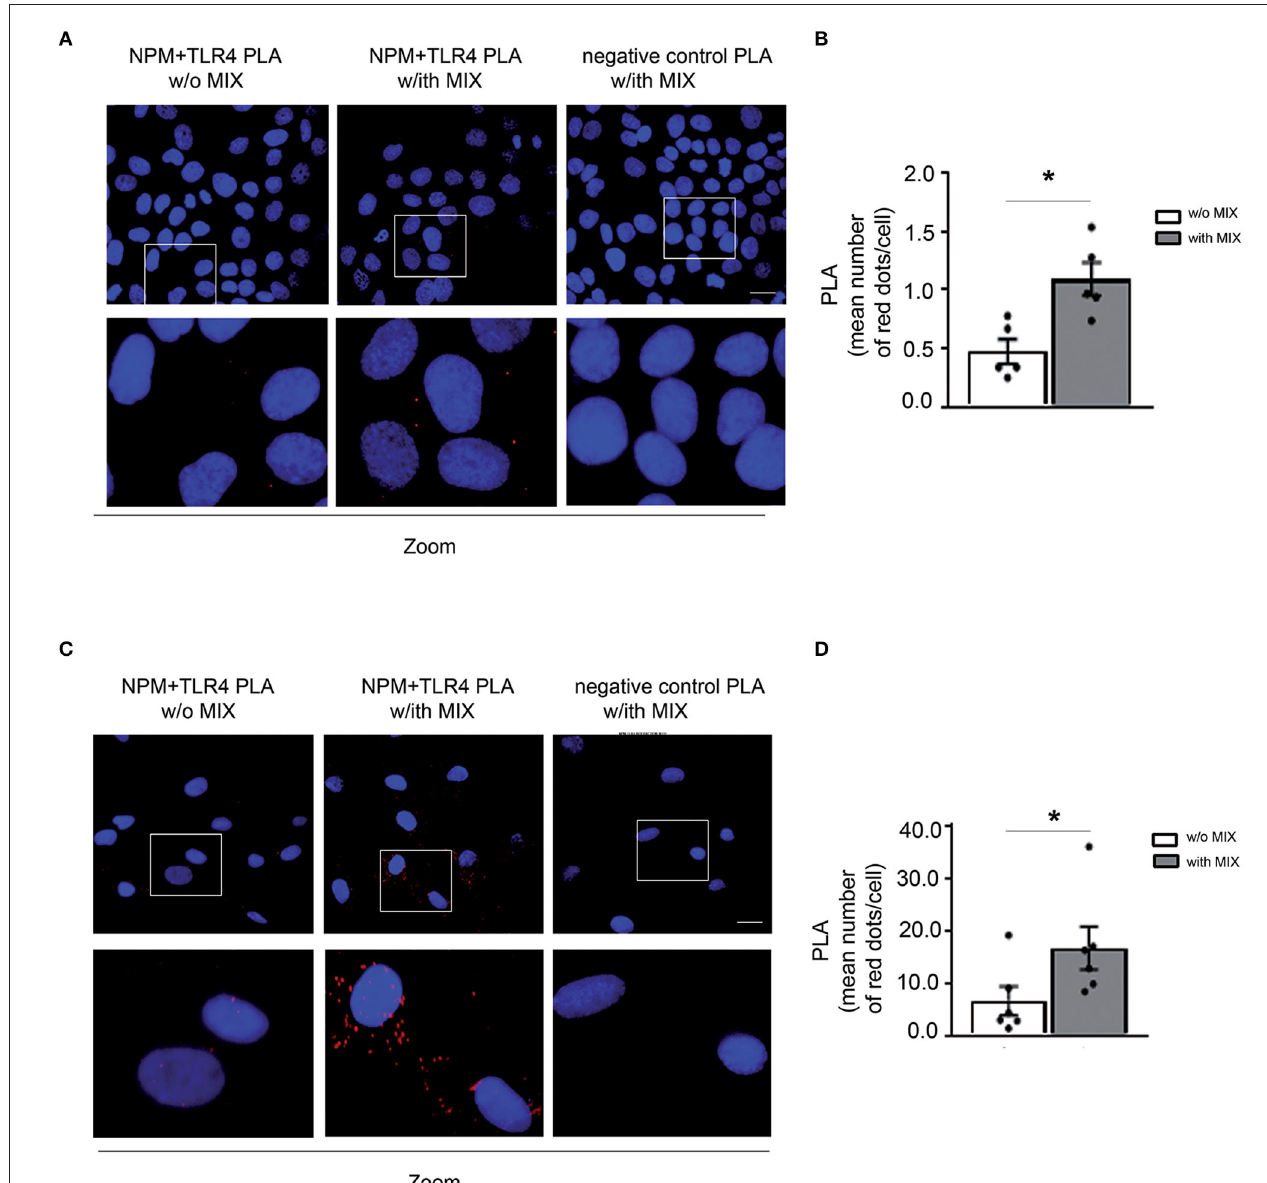
FIGURE 4 | eNPM binds to TLR4 and the binding increases upon cytokines treatment in HaCaT and HFs. (A) Proximity ligation assay (PLA) of NPM and TLR4 interaction analysis in serum-starved HaCaT cells stimulated with a MIX of cytokines for 8h (IL-17A, IL-22, TNF- α , and IFN- γ ). Lower panels represent zoomed-in images of the original PLA images. Red dots indicate that even under physiological conditions, NPM interacts with TLR4. When a MIX of cytokines is administered, the rate of interaction increases. As a negative control, the IgG specific for each antibody (i.e., normal rabbit IgG used as the control of TLR4 antibody) and normal mouse IgG for NPM antibody (left panel) revealed the specificity of NPM and TLR4 interaction, since no red dots were present in the PLA. Scale bar 10 µ m. (B) Bar graph of PLA interactions quantified by the mean number of red dots per cell ( n = 5; * p < 0.05). (C) PLA of NPM and TLR4 interaction analysis in serum-starved HFs derived from healthy subjects and stimulated with a MIX of cytokines for 8h. Lower panels represent zoomed-in images of the original PLA images. Scale bar 10 µ m. (D) Bar graph of PLA interactions quantified by the mean number of red dots per cell ( n = 6; * p < 0.05).